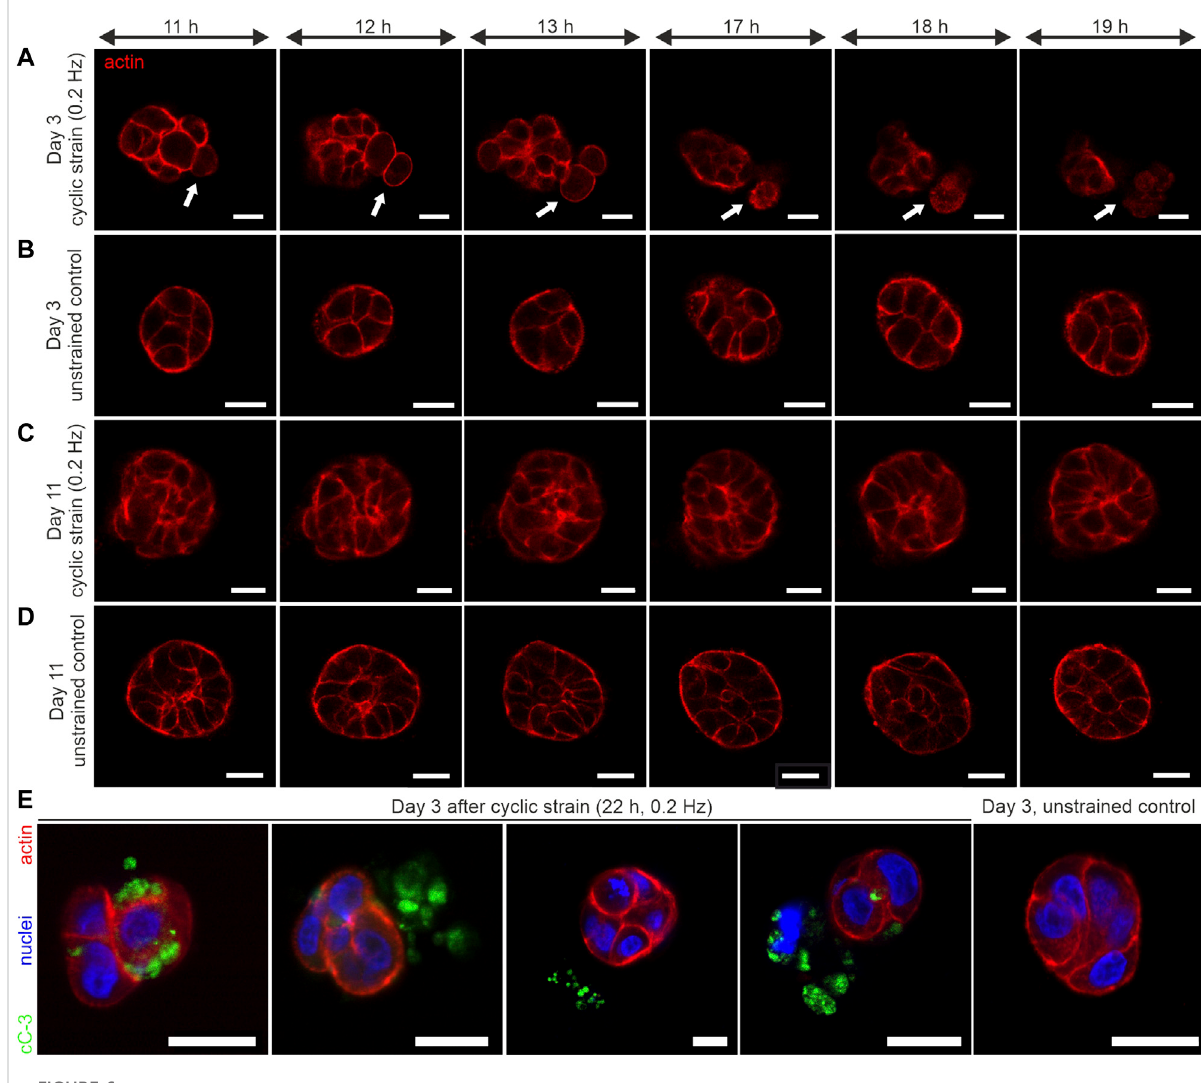
FIGURE 6 Long-term cyclic shearstraintriggerscell extrusion andapoptosis invery earlydevelopmentalstagesofbreastspheroids . MCF10A/RFP-LifeAct spheroidswerecultivatedfor3and11 daysbeforebeingsubjectedtocyclicstrainfor22 h(0.2 Hz,pos-1andpos+1=5 mm). (A) Therepresentative imageseries depicts theextrusion of2 cellsfrom avery earlydeveloped (day3 – 4) spheroidbody (whitearrows). (B) Representative imageseries ofa corresponding unstrained control sample. For complete image series of A and B, see Supplementary Movies S1, S2. (C) Image series of a representative strained spheroid (low-developed, day 10 – 11). (D) Representative image series of a corresponding unstrained control sample. (E) Shows four individual spheroids fi xed and stained against cleaved Caspase-3 (cC-3) protein after 22 h of cyclic strain treatment. An unstrained control sample with the absence of cleaved caspase-3 is shown. All scale bars = 20